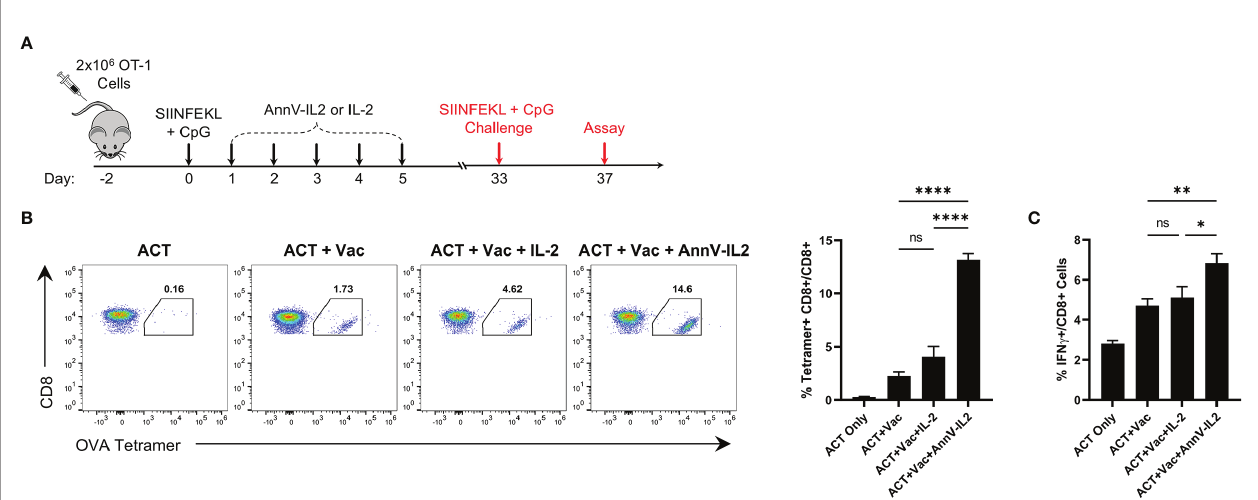
FIGURE 5 | AnnV-IL2 promotes larger memory cell pool capable of enhanced secondary expansion. (A) Schematic of experimental design. Naive C57BL/6 mice received 2x106 OT-1 cells intravenously on day -2, followed by intraperitoneal injection of the peptide corresponding to the immunodominant epitope of OVA (OVA257-264; SIINFEKL) and TLR9 agonist, CpG, on day 0. Mice were treated with equimolar amounts of AnnV-IL2 or IL-2 intraperitoneally once daily for a total of 5 days. Mice were challenged with SIINFEKL peptide and CpG on day 33. N=5 mice per group. (B) PBMC ’ s were isolated on day 37 and antigen speci fi c cells were quanti fi ed by tetramer staining. Dot plots are representative of one mouse in each group. Bar chart depicts levels of OVA257-264-specifc CD8+ T cells. (C) PBMC ’ s were stimulated with PMA and Ionomycin in the presence of Brefeldin A and monensin for 2 hours and IFN g production was quanti fi ed by intracellular cytokine staining. Bar chart depicts IFN g + CD8+ T cells. Data is represented by mean ± SEM. P values were calculated by ordinary one-way ANOVA with the Tukey-Kramer multiple comparison test, and P < 0.05 is considered statistically signi fi cant. * = < 0.05, ** = < 0.01, **** = < 0.0001. NS, not signi fi cant. OVA, Ovalbumin; TLR, Toll- like receptor; PBMC, peripheral blood mononuclear